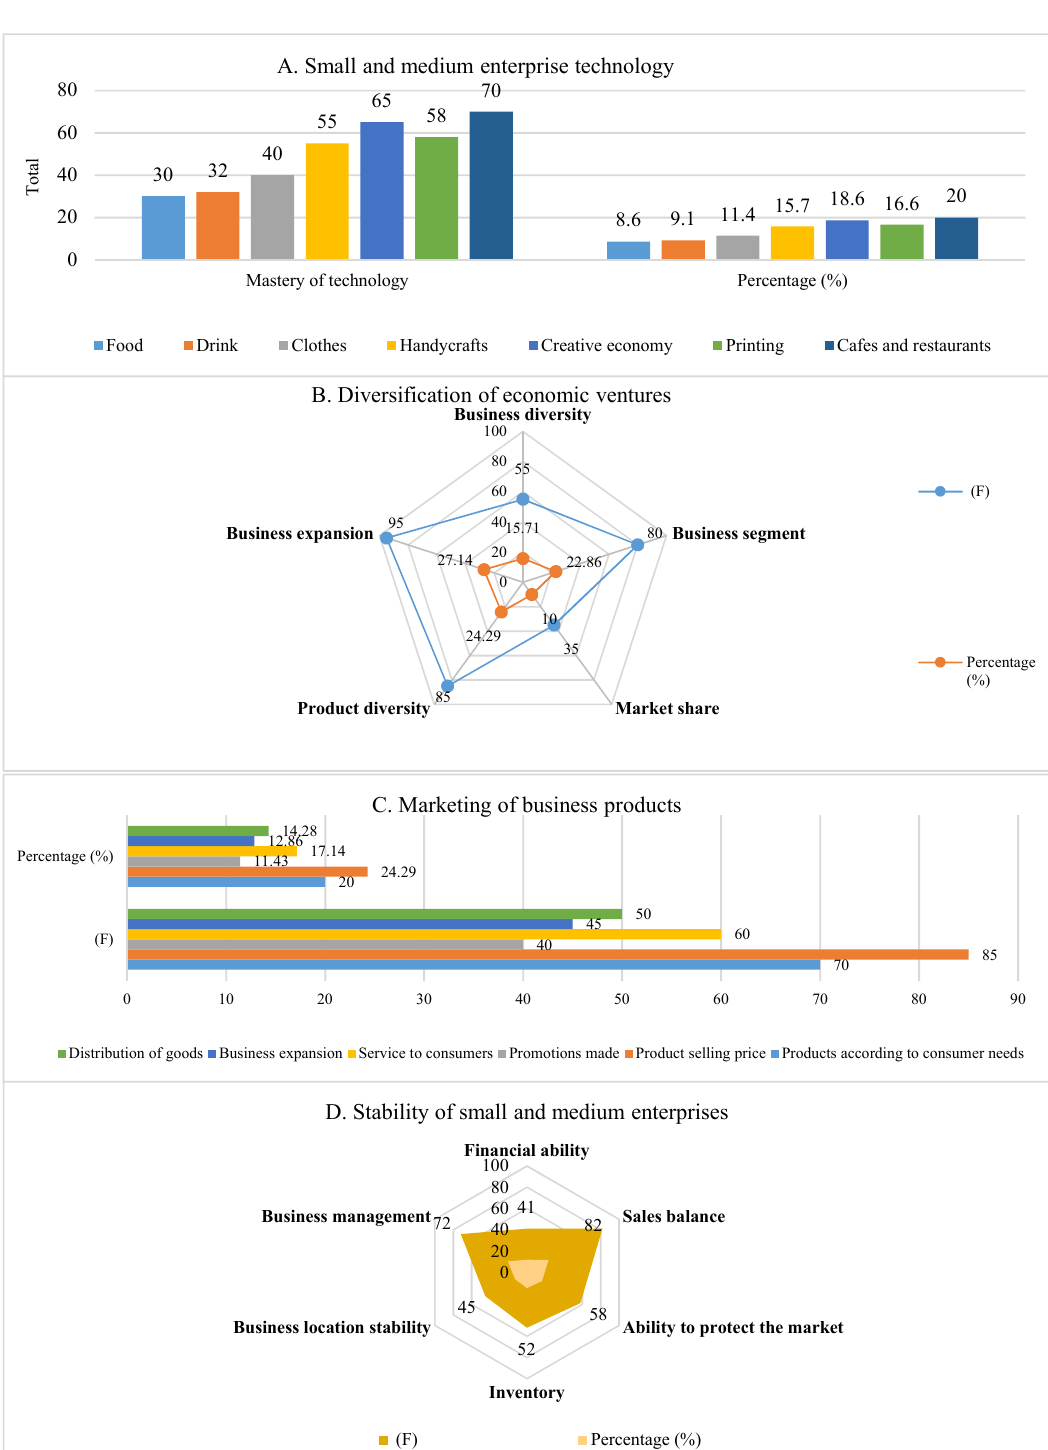
Figure 7. Examples of SMEs: ( A ) technological innovation, ( B ) business diversification, ( C ) product marketing, and ( D ) business stability. Source: primary data.